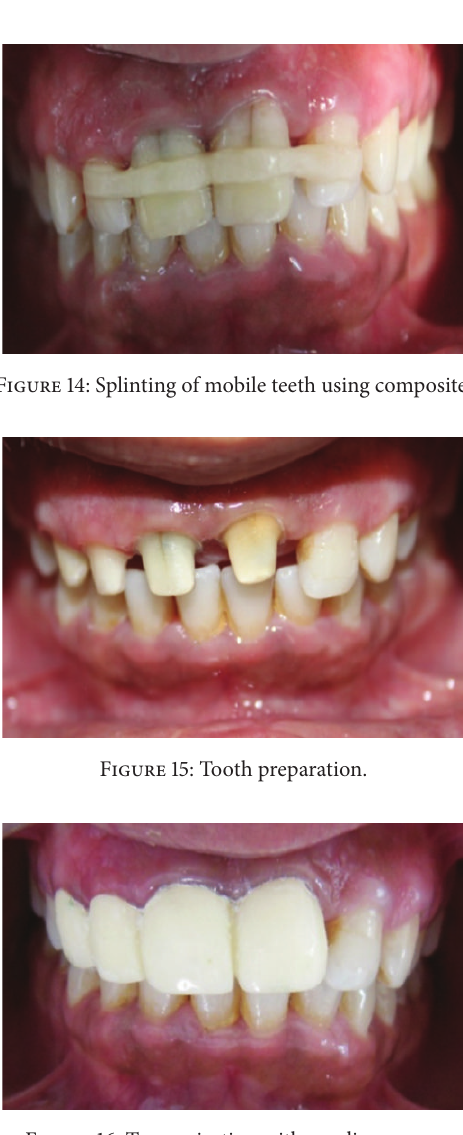
Figure 16: Temporization with acrylic crowns.